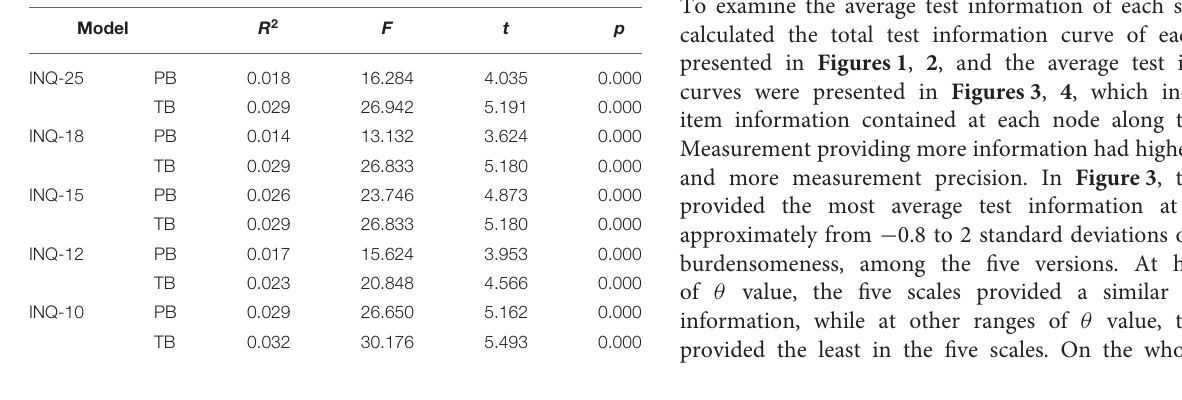
TABLE 4 | Regression models of perceived burdensomeness and thwarted belongingness predicting acquired capability for suicide.